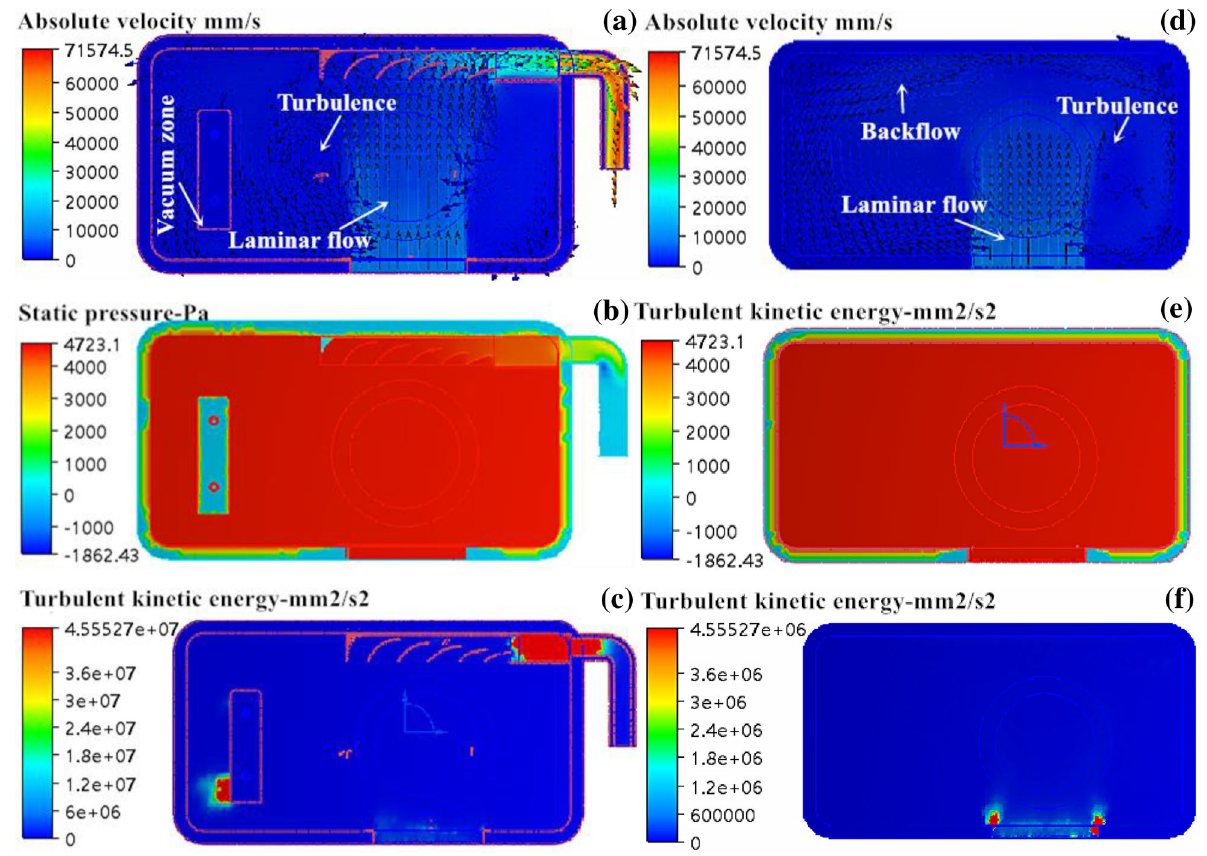
Figure 8. Simulation results of mold flow in forming cavity: ( a ) and ( d ) are velocity distribution diagrams; ( b ) and ( e ) pressure profiles; ( c ) and ( f ) turbulence